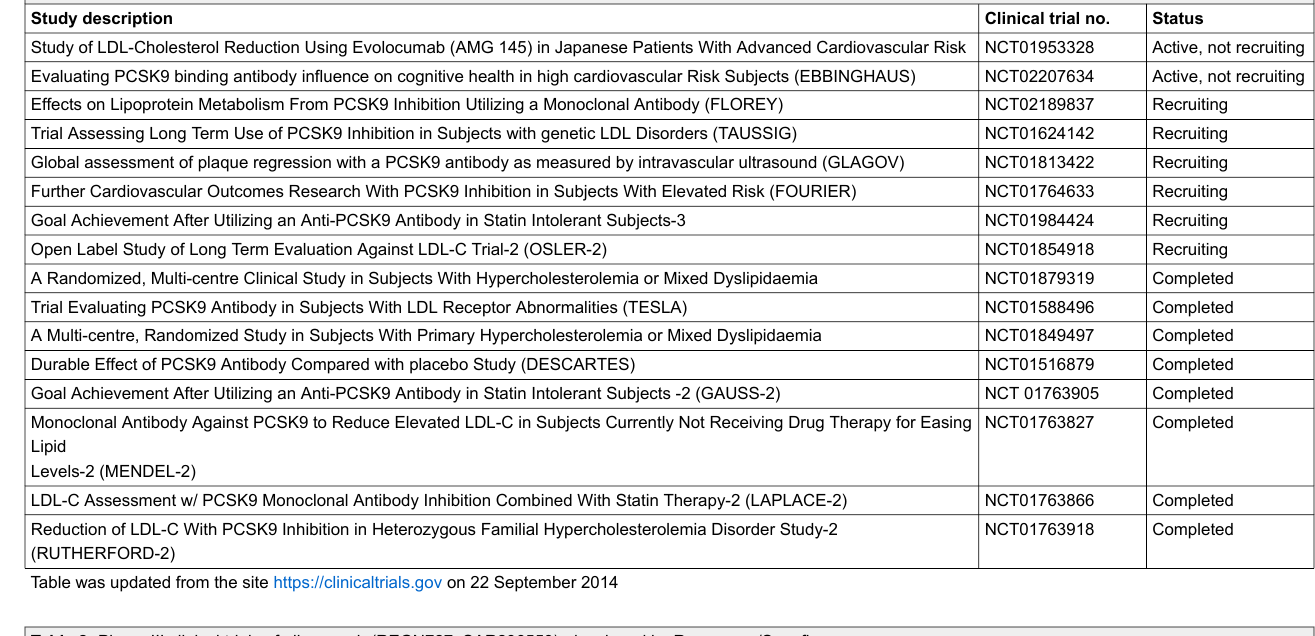
Table 2: Phase III clinical trials of alirocumab (REGN727, SAR236553), developed by Regeneron/Sanofi. Study